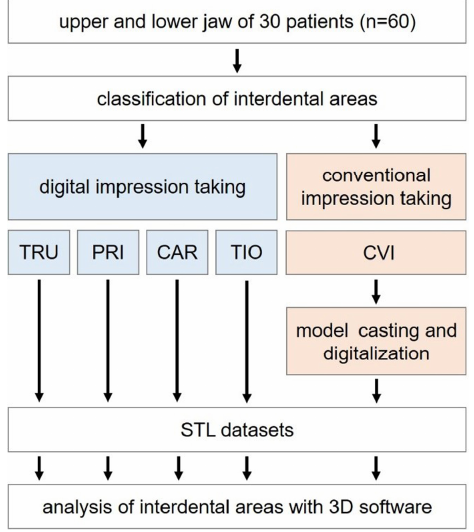
Figure 2. Flow scheme of the clinical trial.